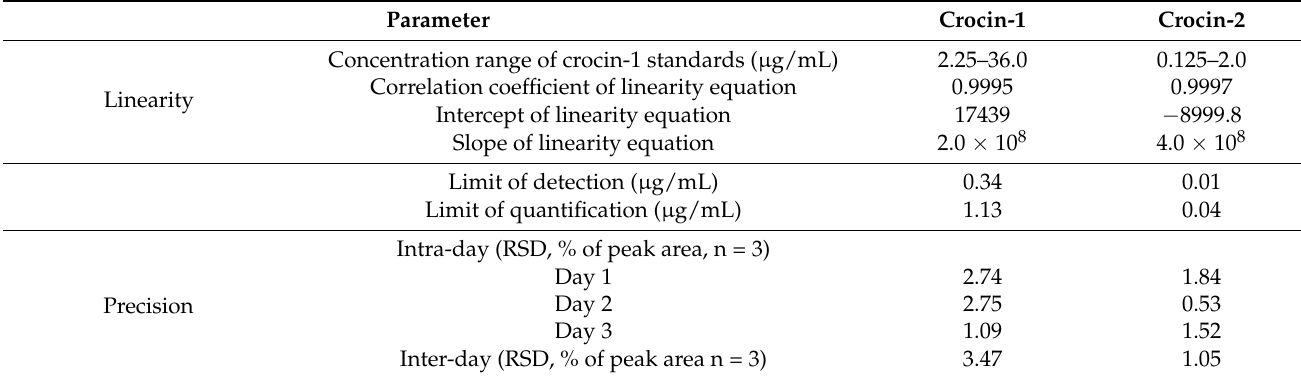
Table 2. Validation parameters. RSD, relative standard